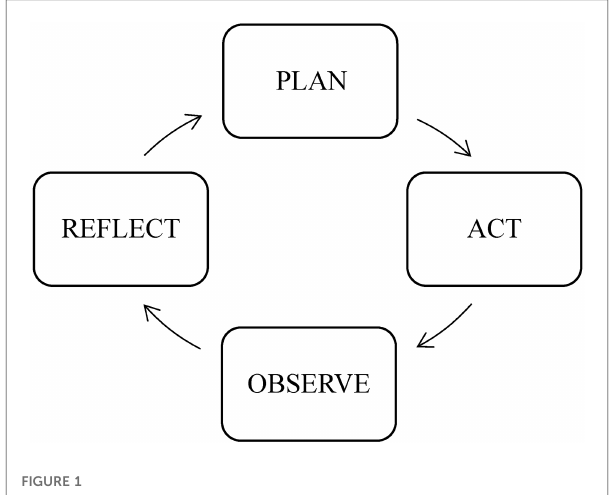
FIGURE 1 Action research ’ s